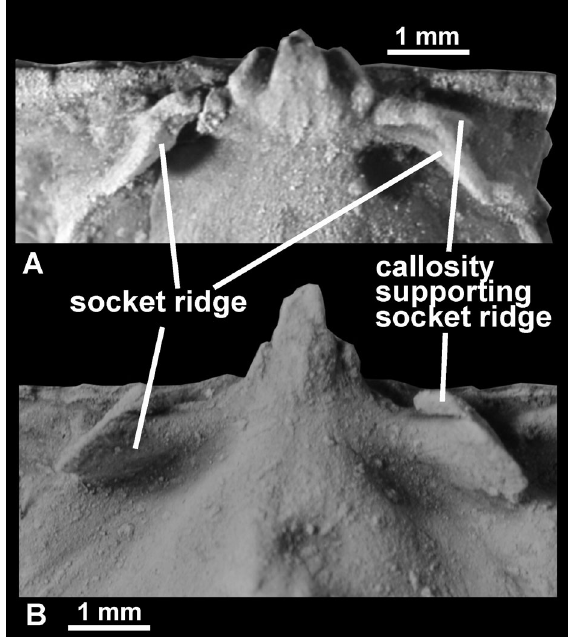
Fig. 3. Views of cardinalia: A , Sampo suduvensis sp. nov., dorsal valve VU B23. B , Sampo hiiuensis Öpik, dorsal valve GIT